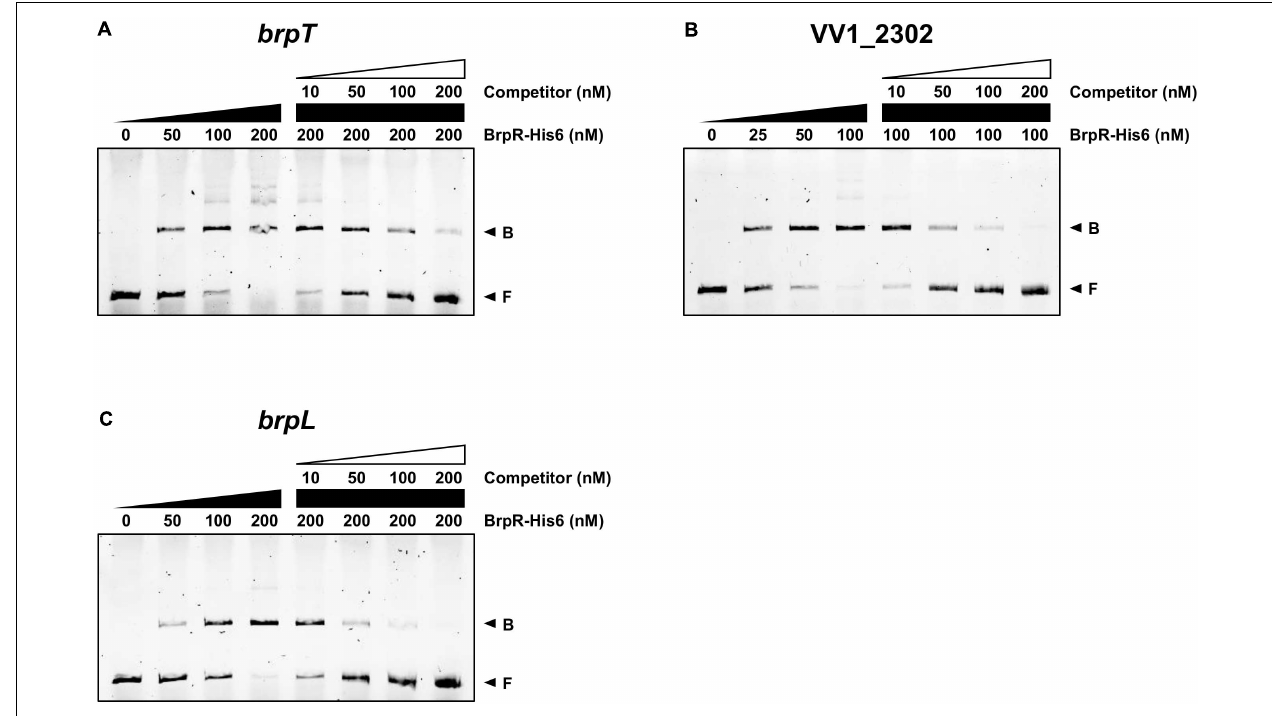
FIGURE 9 | Direct binding of BrpR-His6 to upstream regions of the BrpR regulon. The 6-FAM-labeled DNA fragments (5 nM) for the upstream regions of brpT (A) , VV1_2302 (B) , and brpL (C) were incubated with increasing amounts of BrpR-His6 as indicated in the presence of c-di-GMP (50 µ M). For competition analysis, the same but unlabeled DNA fragments were used as self-competitors. Various amounts of self-competitors were added as indicated to the reaction mixtures before the addition of BrpR-His6. B, bound DNA; F, free DNA.